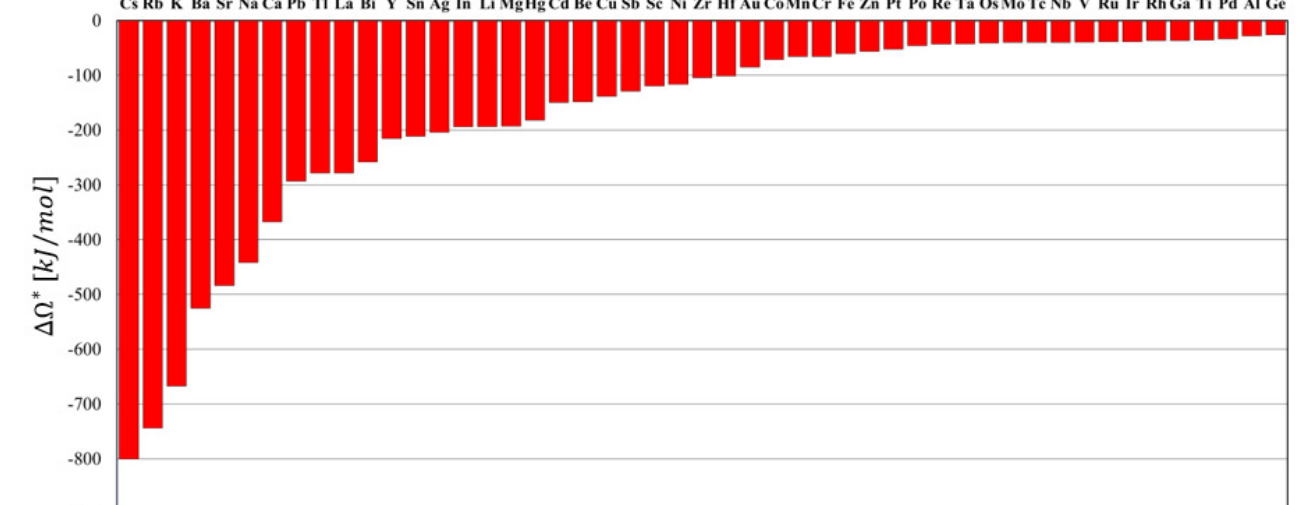
Figure 1. Value of the critical interaction energy difference ∆𝛺 ∗ of W-based alloys.